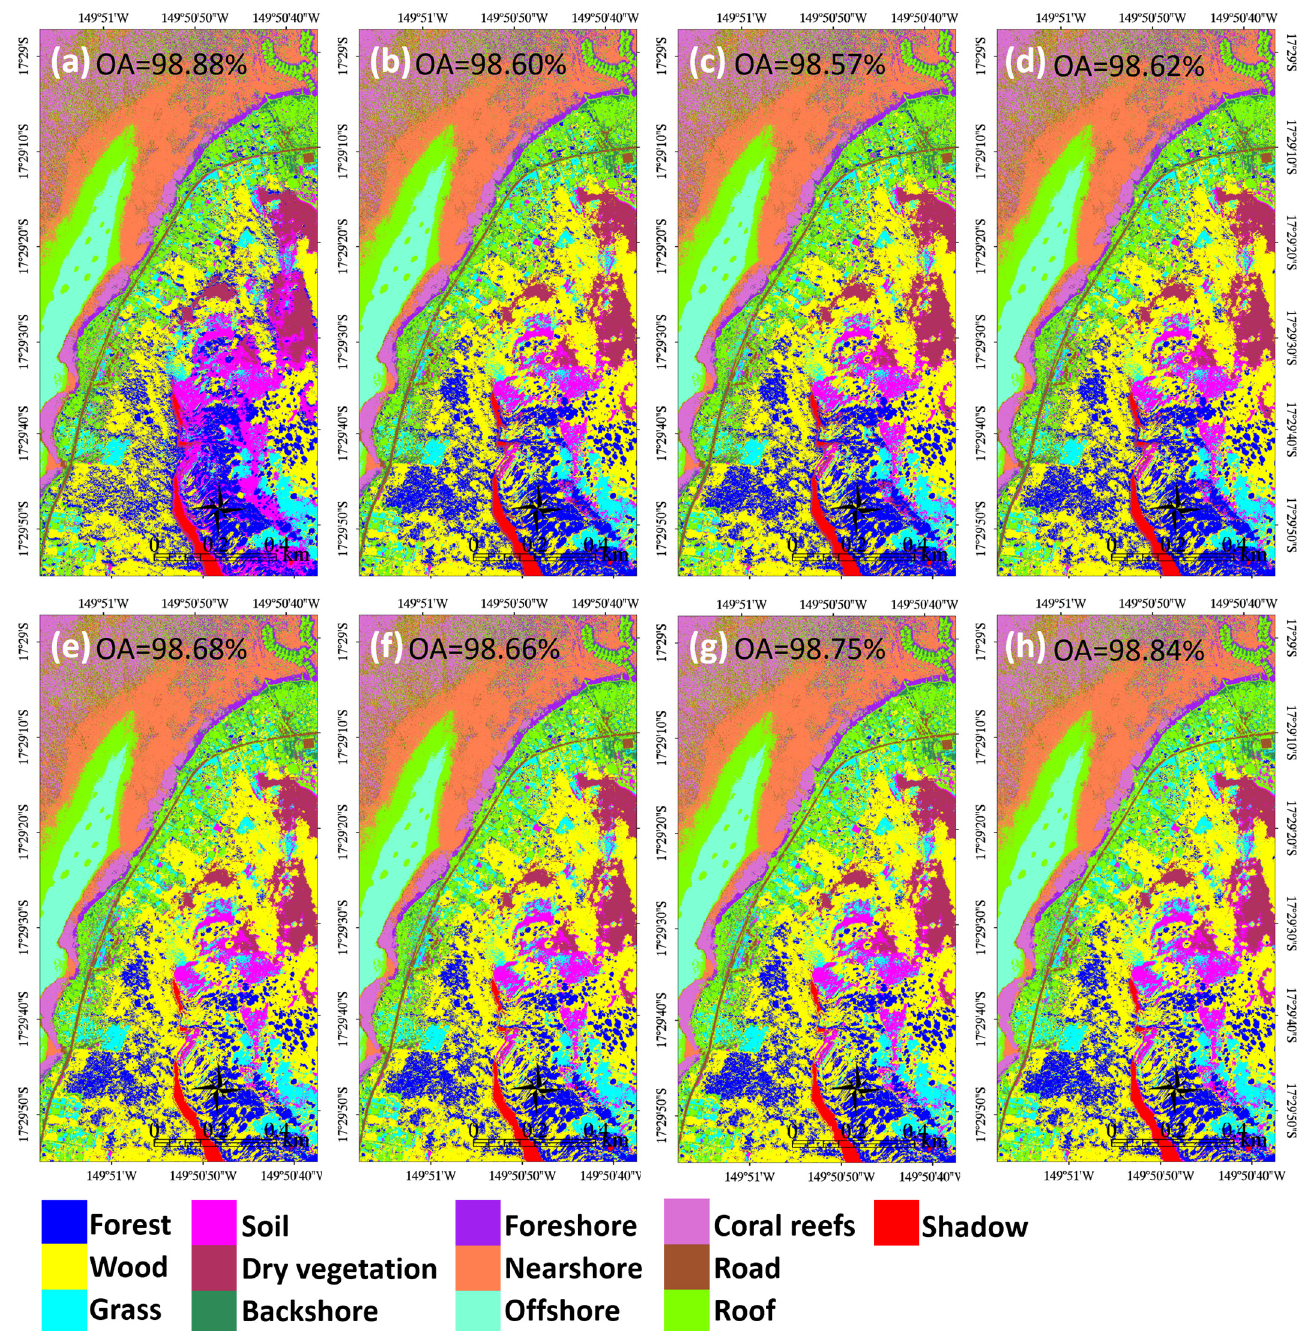
Figure 8. Maximum likelihood classification maps of the land-sea coral reefscape using WorldView-3 topobathymetric digital surface model and optical dataset with: ( a ) Mid-InfraRed1 (MIR1); ( b ) MIR2; ( c ) MIR3; ( d ) MIR4; ( e ) MIR5; ( f ) MIR6; ( g ) MIR7; ( h ) MIR8.